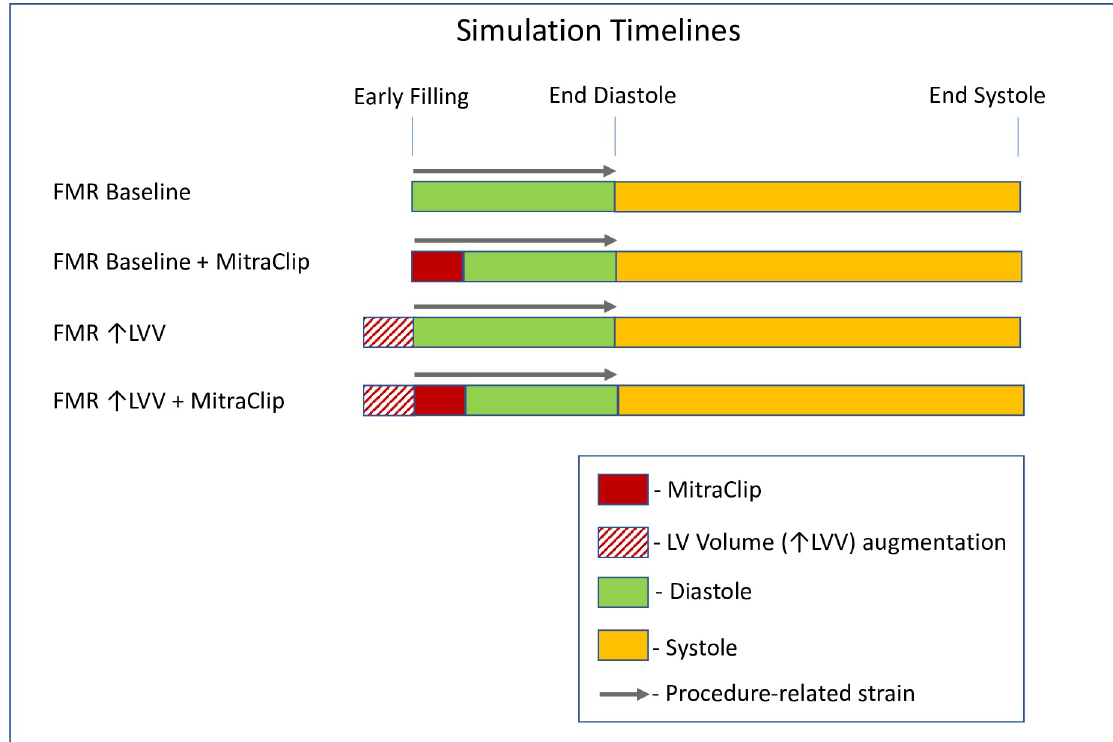
Fig 2. The simulation